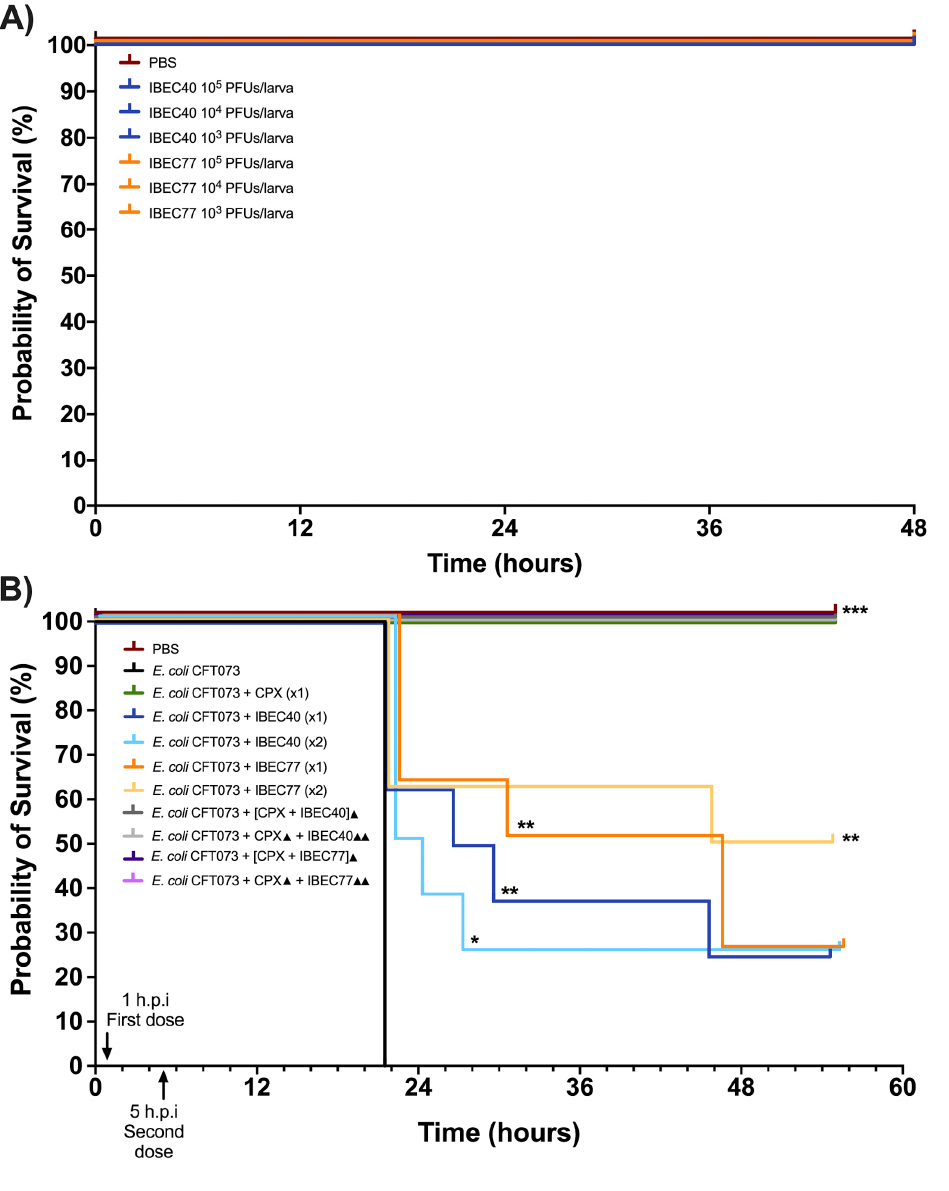
Figure 6. In vivo toxicity of E. coli CFT073, IBEC 40, and IBEC 77 in G. mellonella larvae and effective survival concentration for in vivo phage therapy. ( A ) Different concentrations of IBEC 40 and IBEC 77 phages showed no toxic effects on the survival of G. mellonella larvae over 48 h of inoculation. ( B ) Survival curve of G. mellonella larvae with effective concentrations of E. coli CFT073 and IBEC 40 and IBEC 77 phages alone and in different combinations with ciprofloxacin (20 mg/kg larva) for studying the prolongation of larvae survival, compared with the bacterial host strain alone. For the individual treatments of phages, the clarification x1 indicates one dose at 1 h post-infection (h.p.i) and the clarification ×2 indicates two doses (the first dose at 1 h.p.i and the second dose at 5 h.p.i). In the combined treatments of phages with the antibiotic, the Δ clarification in the legend indicates one dose at 1 h.p.i and ΔΔ indicates 2 h.p.i. Larvae were monitored up until 55 h after inoculation. Graphs were plotted with GraphPad Prism version 9.0. Statistically significant differences (* p < 0.05, ** p < 0.01, *** p < 0.001) between all treatments and the E. coli CFT073 were determined with GraphPad Prism version 9.0, by using the Long-rank test and Gehan–Breslow–Wilcoxon